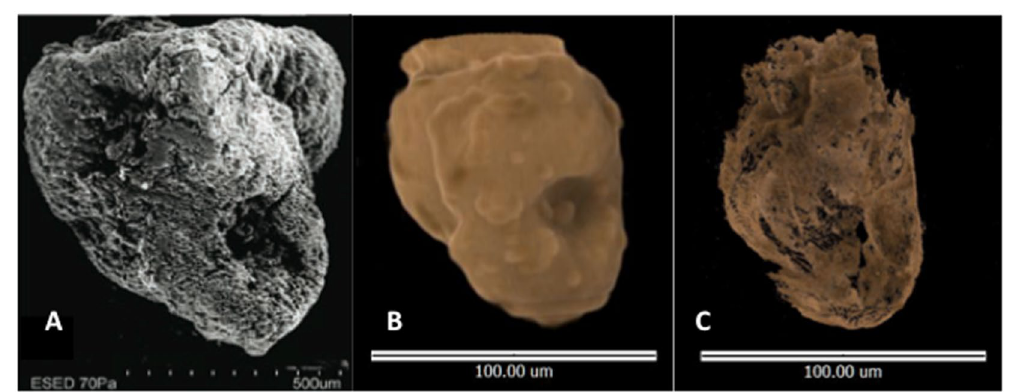
Figure 4. ( A ) – SEM image of domesticated-type rice spikelet base (from Fuller et al . 4 Fig. 3G). ( B ) – Tomographic image of domesticated-type spikelet base in Sherd 3 from Loc Giang (Animation S8). ( C ) – Tomographic image of domesticated-type rice spikelet base in Sherd 1 from An Son (Animation